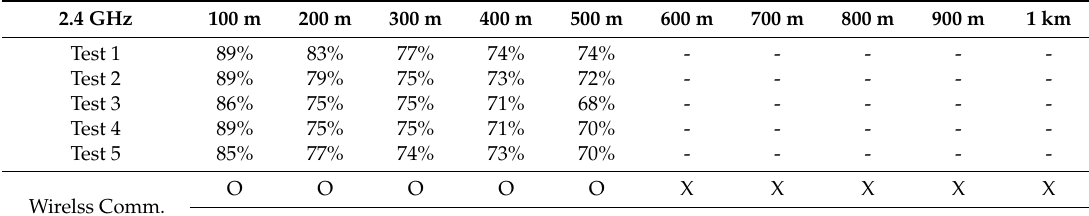
Table 1. Wireless communication distance and receive sensitivity at WiFi 2.4 GHz.